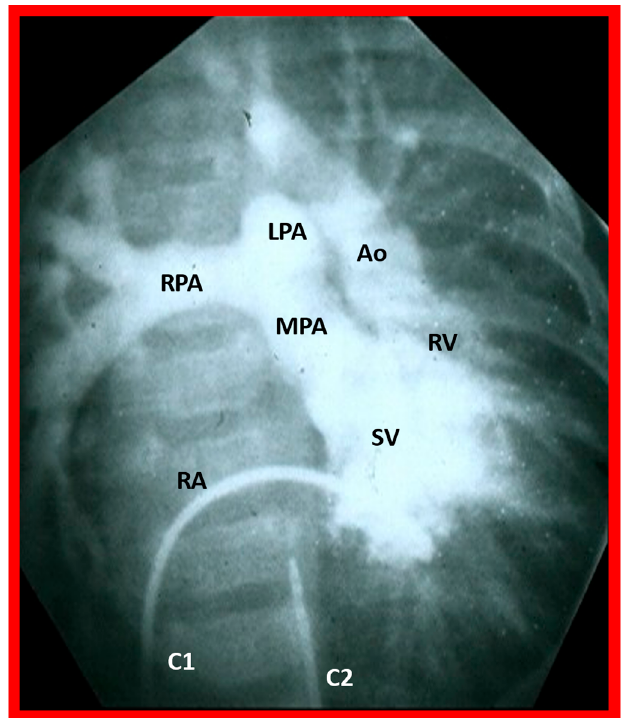
Figure 32. Selected angiographic image in the posteroanterior view of a patient with a single ventricle (SV) illustrating opacification of the main pulmonary artery (MPA) from the main ventricular chamber and the aorta (Ao) arising from a smallish right ventricle (RV). The Ao is situated to the left of the pulmonary artery, signifying the l-transposition of the great arteries. C1. The catheter in the unmarked inferior vena cava was advanced into the right atrium (RA) and then manipulated into the ventricle; C2. Catheter in the unmarked descending aorta. The left pulmonary artery (LPA) and right pulmonary artery (RPA) are labeled. Reproduced from reference [31].